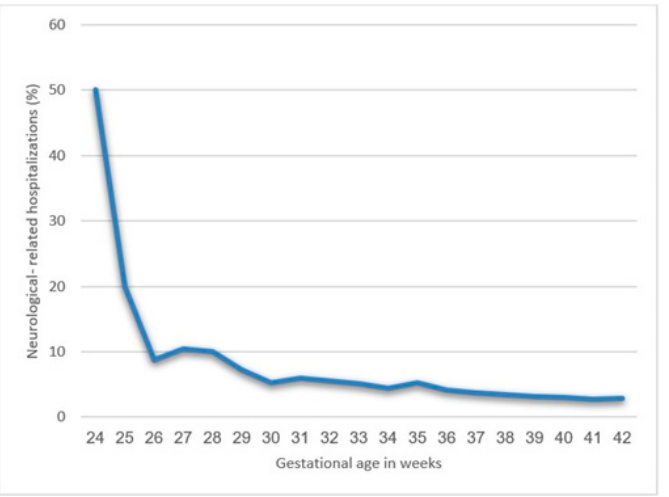
Figure 3. A Kaplan–Meier survival curve demonstrating the cumulative incidence of long-term neurologic-related hospitalizations according to gestational age after year 2000 (Log-Rank test p < 0.001). Figure 4 illustrates univariate analysis of total neurological morbidity according to gestational week at delivery. As seen, the gestational week at birth and neurological morbidity are manifested in an inverse relationship. Searching for a specific threshold, the slope for hospitalization rate attenuated beyond 25 weeks of gestation (Figure 2).